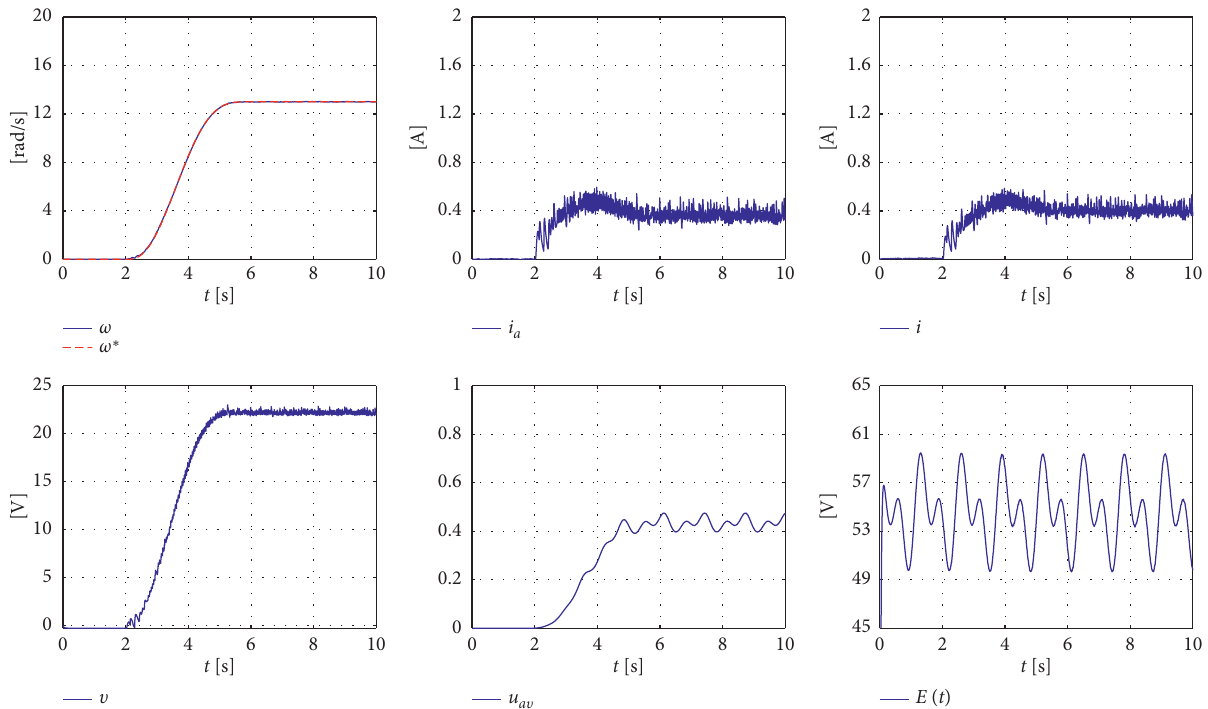
Figure 13: Dynamic response of the DC/DC Buck converter-DC motor system when E ( t ) is defined as in equation (24), experimentally implemented through the TDK-Lambda G100-17 programmable power supply, and considering variations equation (28) in C